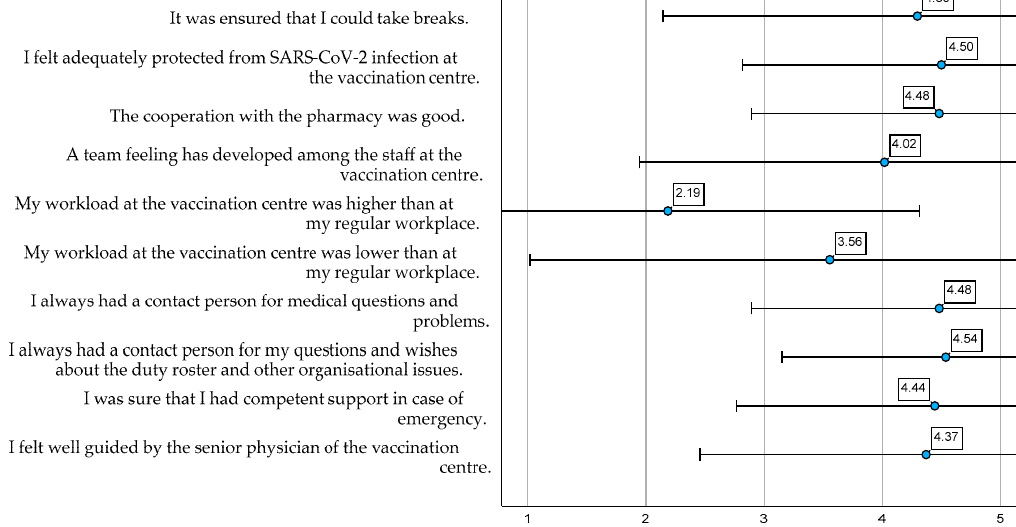
Figure 6. Satisfaction with the working atmosphere at the vaccination centre ( α = 0.705). Mean values, standard deviation of the answers on the five-point Likert scale and Cronbach’s Alpha.